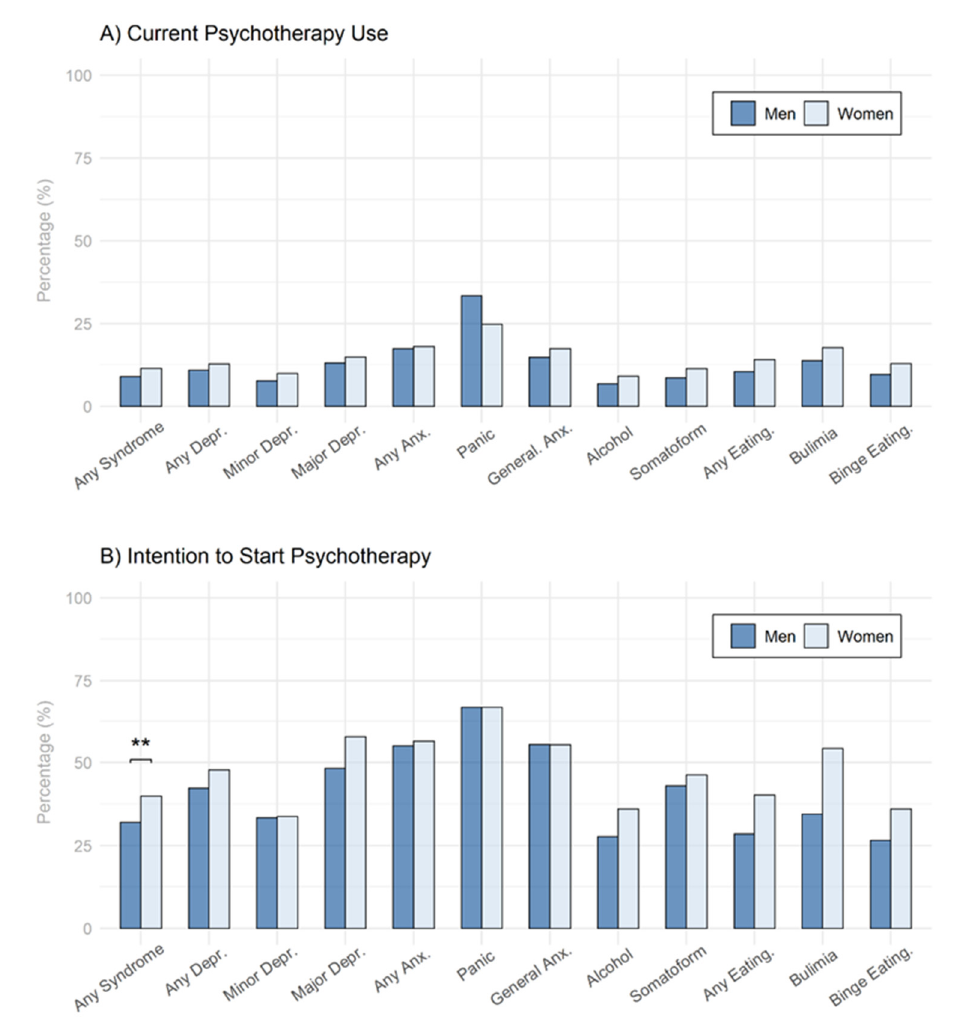
Figure 3. Gender Differences Regarding Psychotherapy Use in different Syndromic Subgroups. ( A ) Gender Differences Regarding Current Psychotherapy Use. ( B ) Gender Differences Regarding Intention to Start Psychotherapy. Note. Depr. = Depression, Anx. = Anxiety, General. = Generalized, Eating. = Eating disorder, PT = Psychotherapy. p -values were adjusted for multiple testing using the Holm–Bonferroni method. ** = p < 0.01.